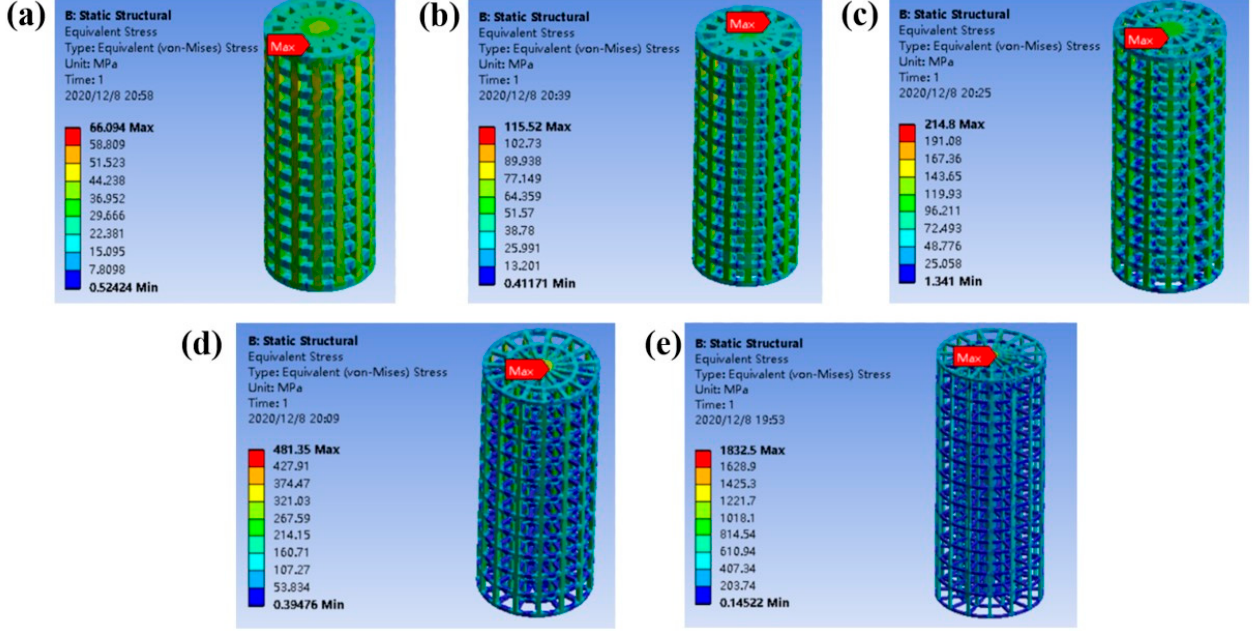
Figure 2. Static equivalent stress cloud diagram of gradient porous structure cylinders with dif- ferent porosities: ( a ) Porosity 45%, ( b ) Porosity 59.86%, ( c ) Porosity 72.87%, ( d ) Porosity 83.00%, ( e ) Porosity